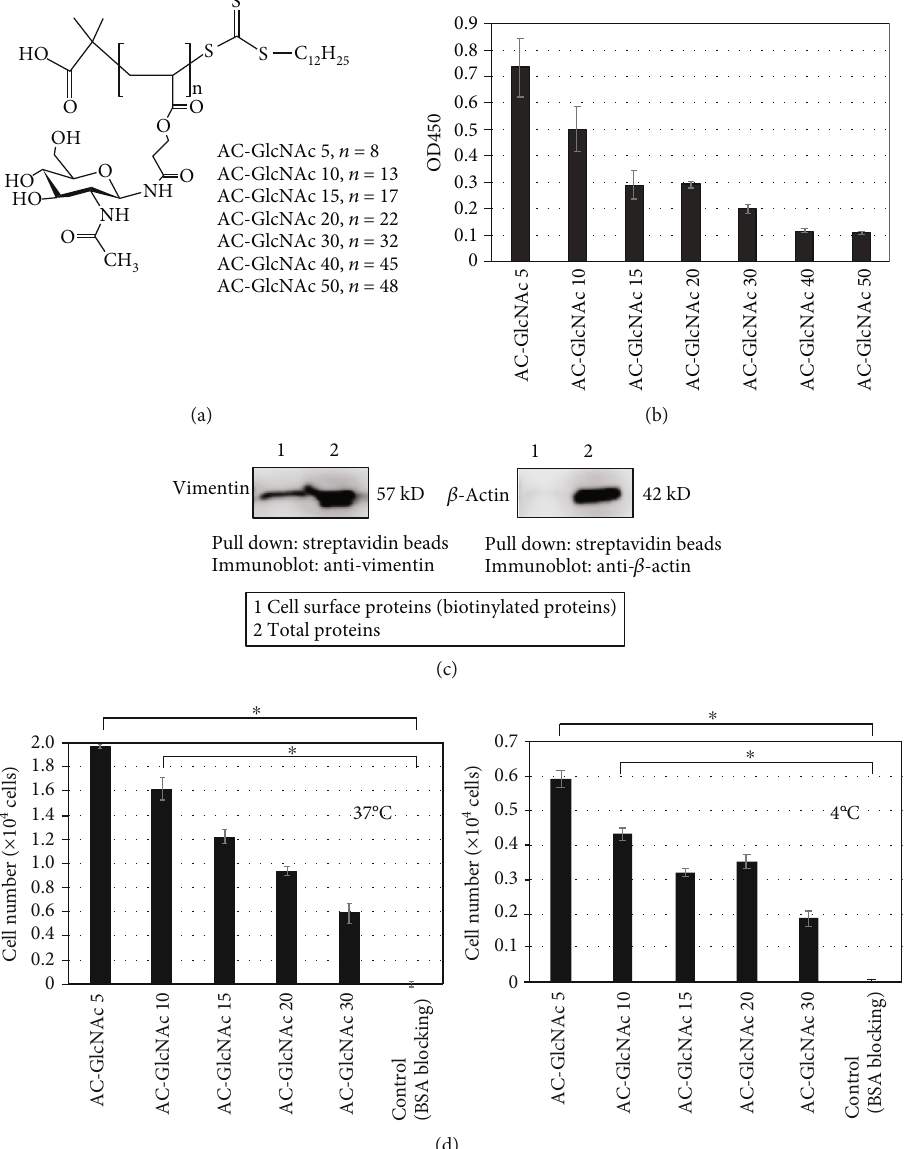
Figure 1: Evaluation of AC-GlcNAc coatings. (a) Structure of AC-GlcNAc. (b) Evaluation of AC-GlcNAc coating on polystyrene dishes using the interaction between biotinylated sWGA and AC-GlcNAc. The amount of biotinylated sWGA on dishes was measured by HRP- neutravidin and TMB solution (absorbance at 450nm). (c) Western blots demonstrating expression of cell-surface vimentin in human immortalized MSCs. (d) UE7T-13 adherence to AC-GlcNAc-coated dishes at 37 (left) and 4 ° C (right). ∗ P < 0 : 01 , n = 3